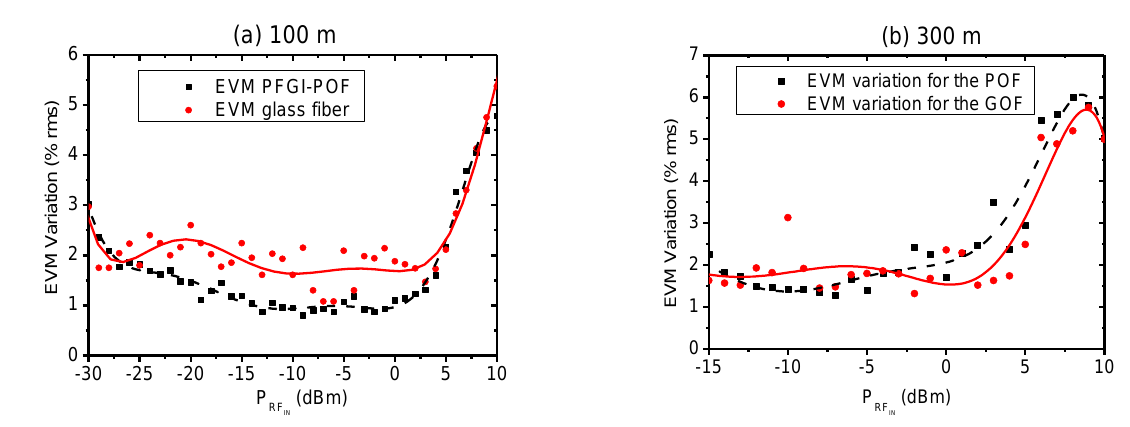
Figure 18. EVM variation as a function of fiber type and length for UMTS signal: ( a ) 100 m; and ( b ) 300 m.